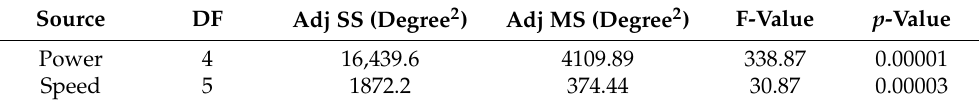
Figure 4. Individual impact of laser power and scan speed on mean contact angle . Table 2. Analysis of variance . Table 2. Analysis of variance.